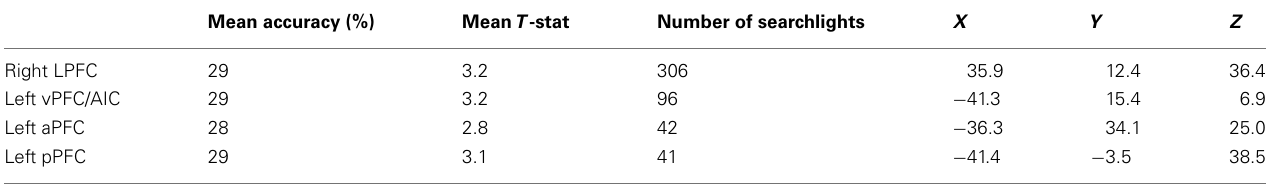
Table 5 | Statistically significant decision rule searchlight clusters.